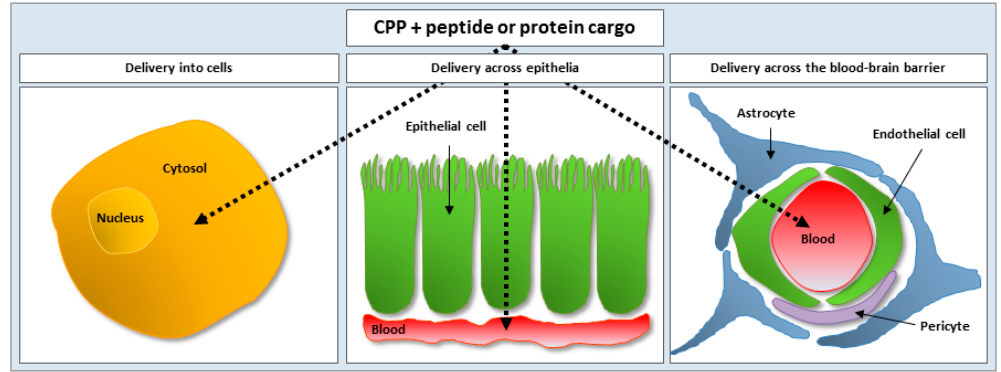
Figure 1. Applications for cell-penetrating peptides for the delivery of peptides and proteins into cells and across epithelia and the blood-brain barrier. Dashed arrows specifies target delivery site being in the cytosol or reached by systemic circulation.